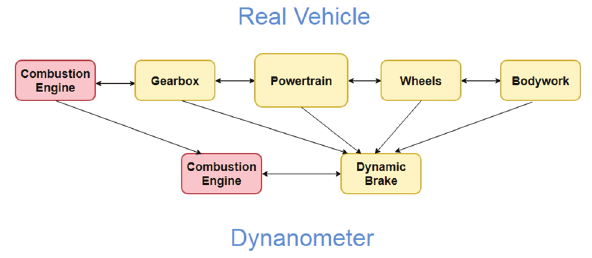
Fig. 4. Diagram of the vehicle simulation process on a test bench